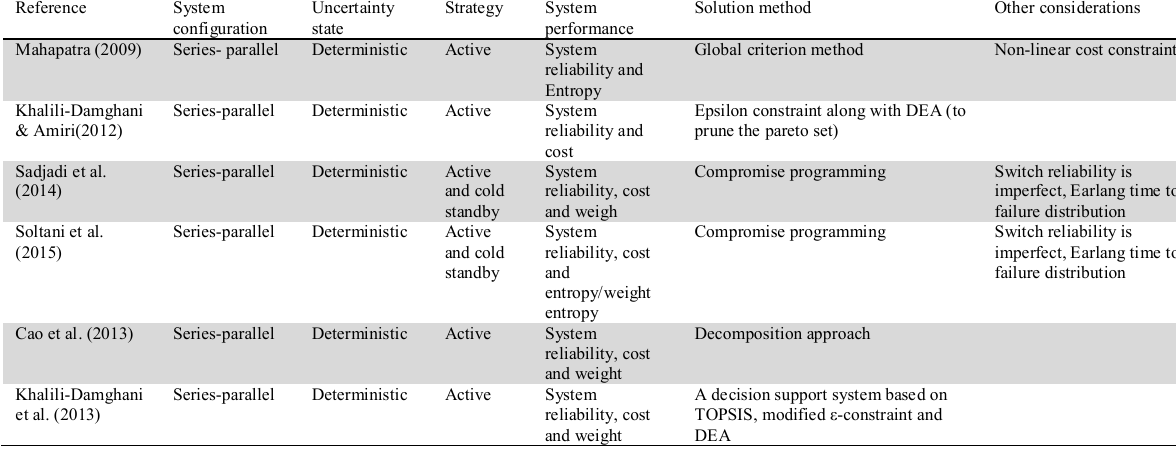
Exact and Mathematical programming approaches for RAP (Multi Objective Problems)